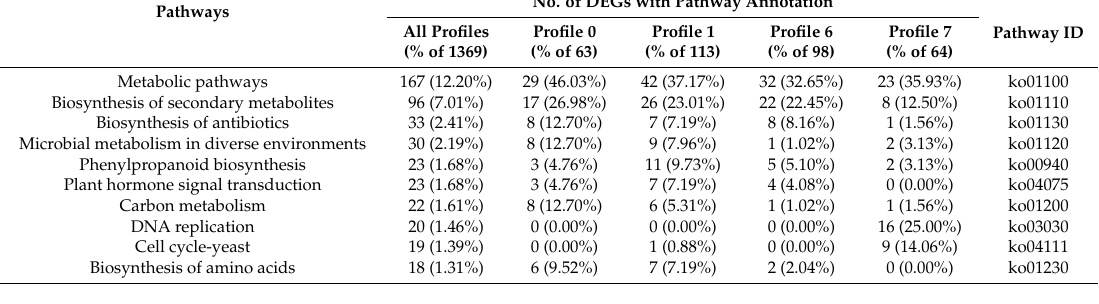
Table 6. 10 top KEGG pathways with a high representation of DEGs.